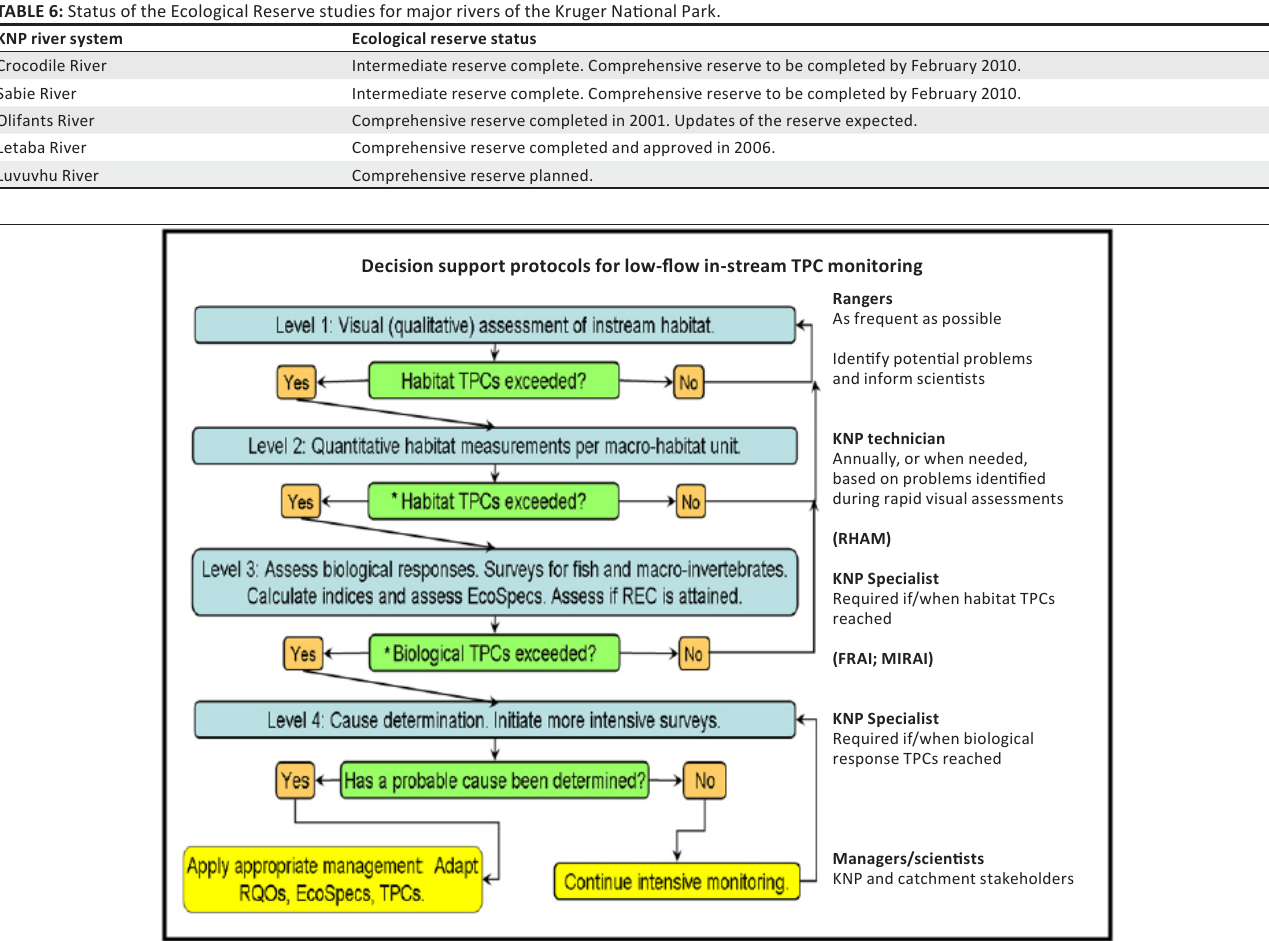
FIGURE 7: Envisaged structured decision-making framework to guide in-stream river biophysical monitoring and decision making associated with implementation of the Ecological